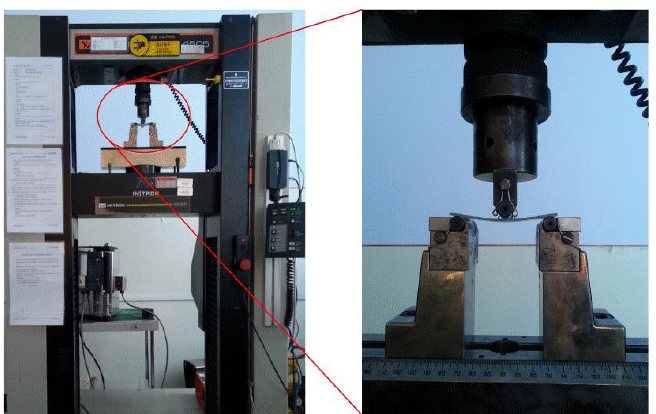
Figure 4. Loading device for bending tests.